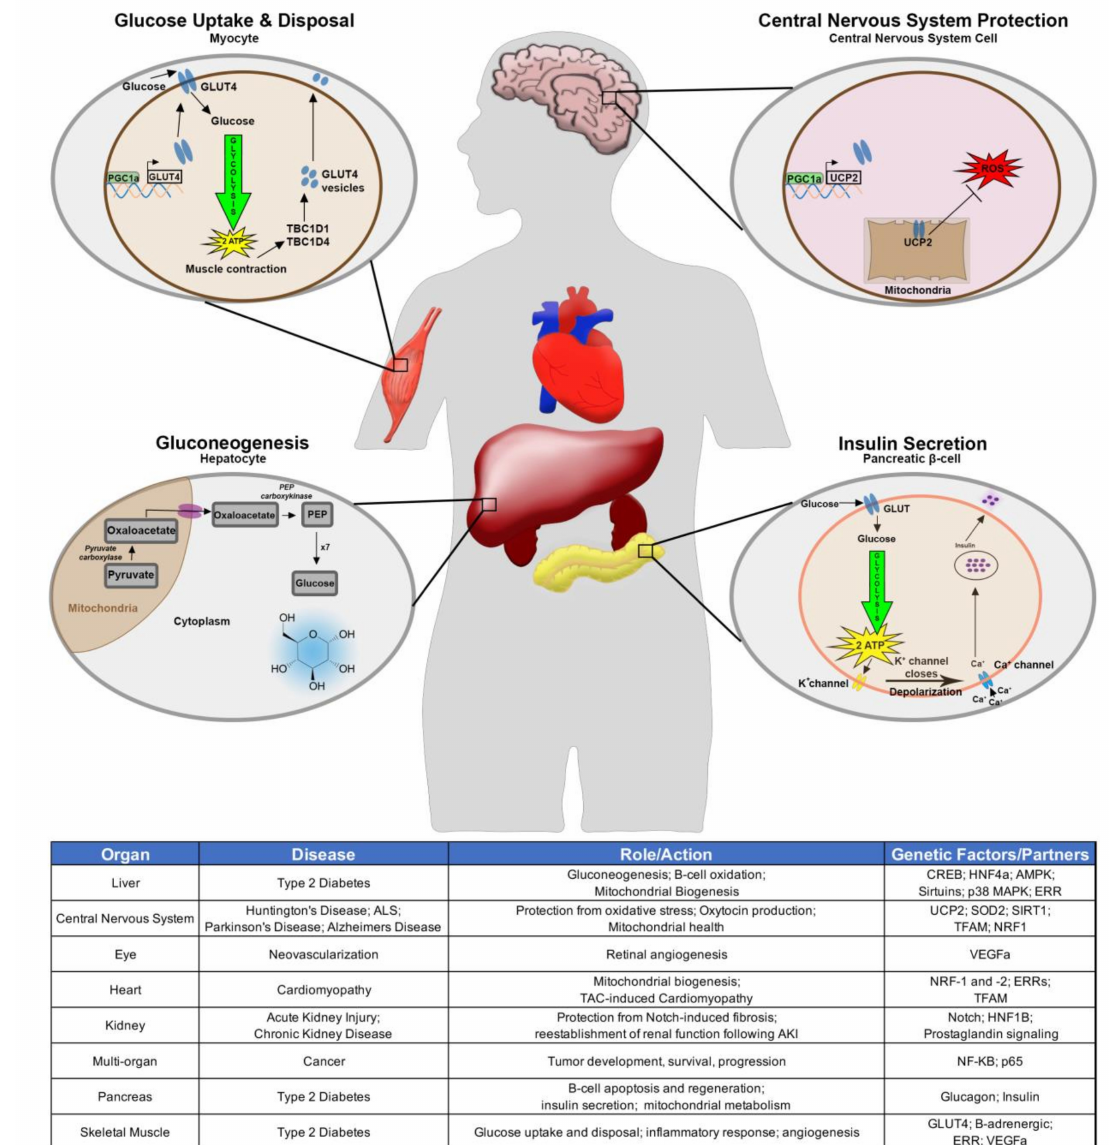
Figure 1. Systems a ff ected and corresponding disease states in peroxisome proliferator-activated receptor gamma co-activator 1 alpha (PGC-1 α ) contexts. Schematic depicting the role of PGC-1 α in select cellular processes including glucose uptake and disposal via glucose transporter 4 (GLUT4) in skeletal muscle (top, left), central nervous system reactive oxygen species (ROS) protection via PGC-1 α uncoupling protein-2 (UCP2) (top, right), gluconeogenesis in the human liver (bottom, left), and insulin secretion from a pancreatic B-cell (bottom, right). Table summarizes key disease states and the associated organ systems in addition to the role PGC-1 α plays in those organs and some of the genetic interactions with PGC-1 α